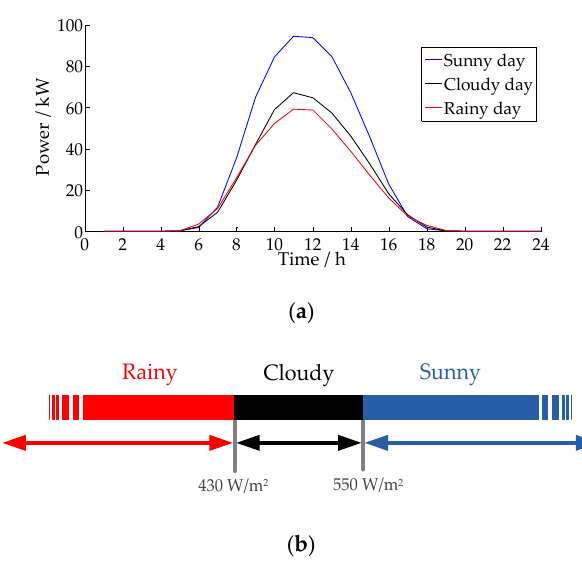
Figure 8. Average PV output curves and range of solar radiation in different weather types. ( a ) The average PV output in different weather types; ( b ) Range of solar radiation in different weather types.